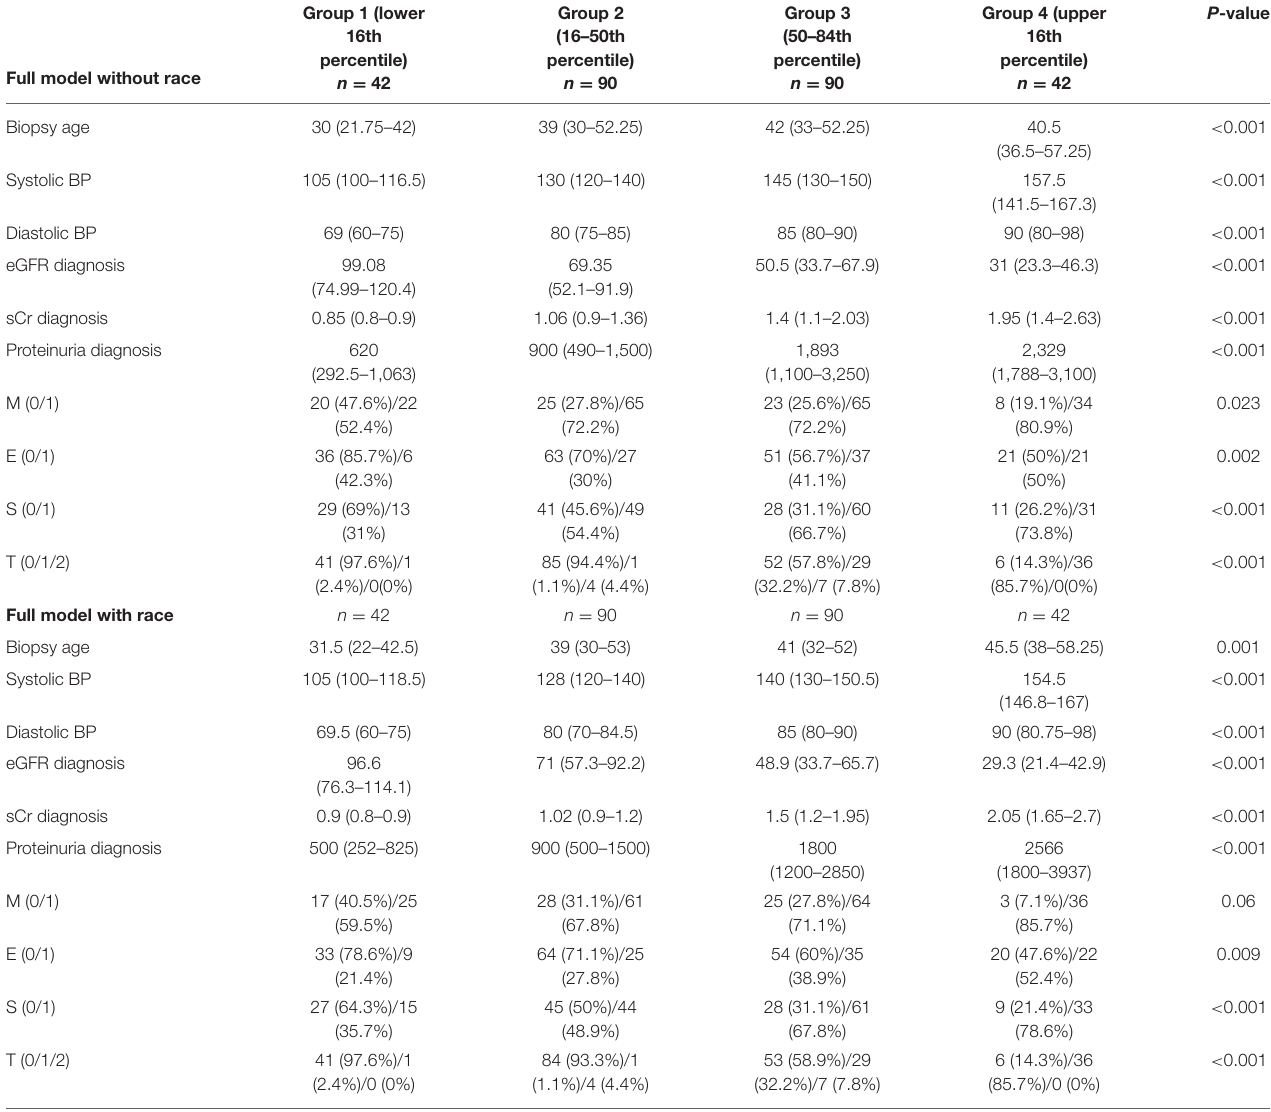
TABLE 2 | Clinical and histological characteristics of groups of patients according to risk stratification based on the full model without and with